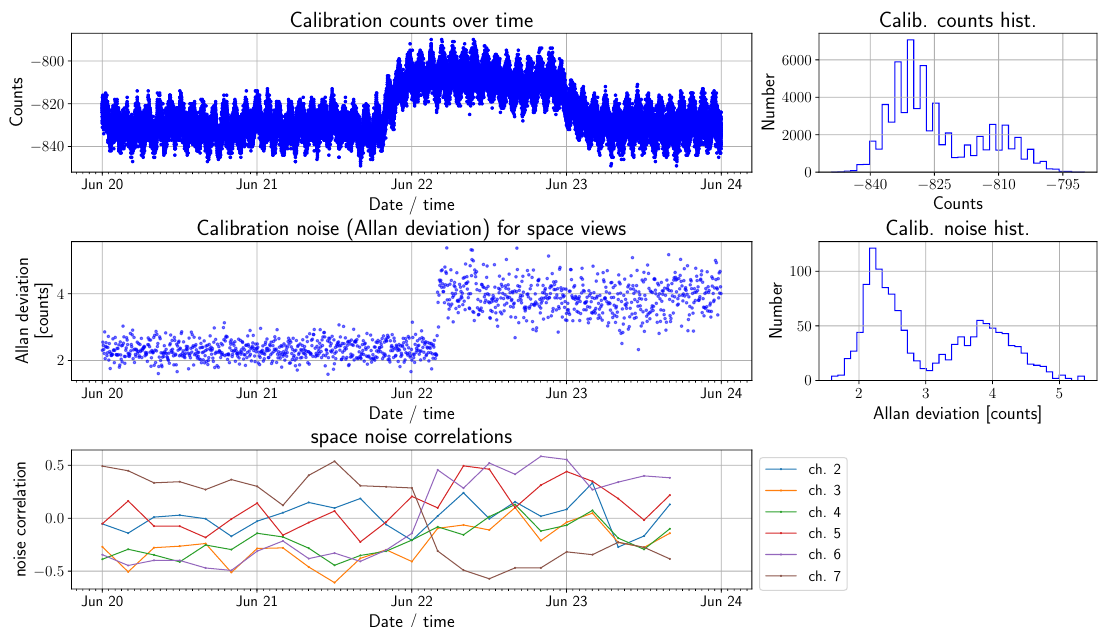
Figure 6. Noise and error correlation behaviour for four days of NOAA-15 channel 1 in June 1999: ( top ) all individual counts for the space views for each set of calibration measurements (48 per set), along with a histogram; ( middle ) the two-sample Allan deviation for each set and a corresponding histogram; and ( bottom ) a time series of the error correlation coefficient for noise between channel 1 and six other channels